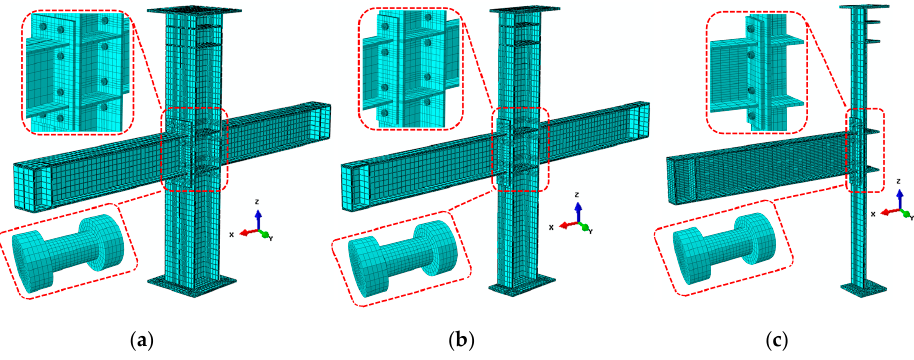
Figure 18. Joint model and mesh of steel part: ( a ) Full-model mesh; ( b ) Half-model mesh; ( c ) Quarter-model mesh.